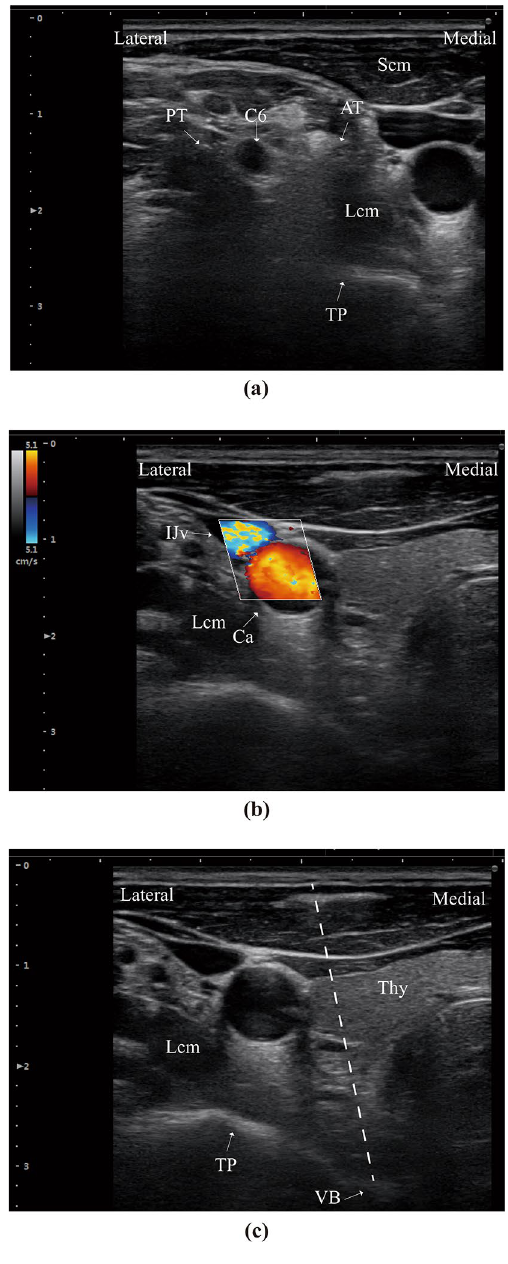
Figure 2. Guidance of C5/6 intervertebral space. ( a ) Characteristic U-type shape of the tubercle at C6 nerve root level. ( b ) Identification of carotid artery and jugular vein with color flow doppler. ( c ) Design of puncturing path (dash line) to the anterior surface of C6 vertebral body. Scm sternocleidomastoid muscle, Lcm longus colli muscle, AP anterior tubercle, PT posterior tubercle, TP sixth transverse process, VB sixth vertebral body, Thy thyroid, C6 sixth cervical nerve root, IJv internal jugular vein, Ca carotid